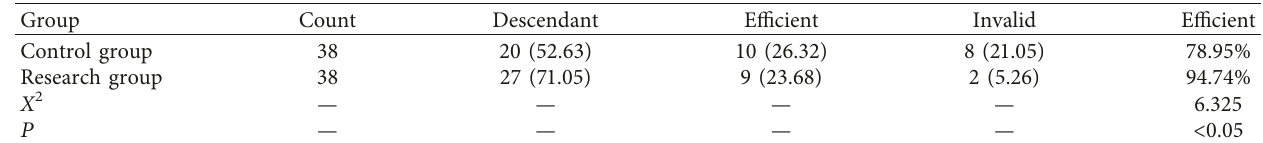
Table 2: Comparison of two groups of treatment results.